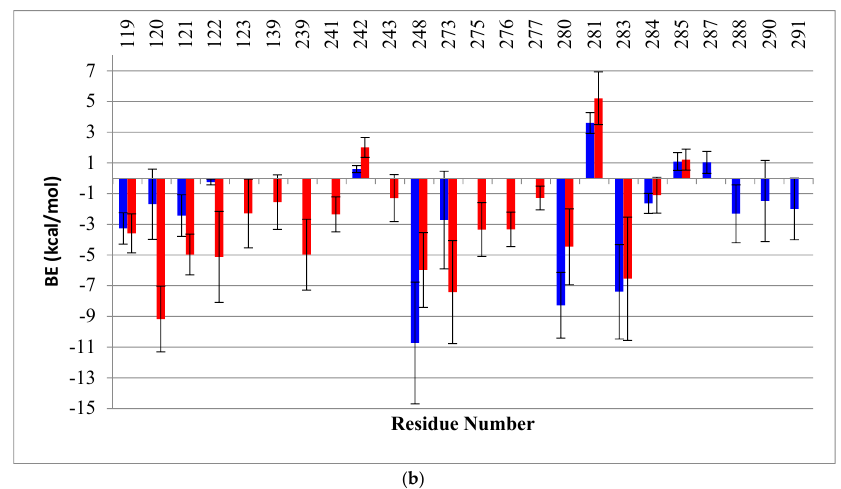
Figure 8. A histogram of the per-residue BE decomposition for ( A ) monomers A and ( B ) monomers B, each in complex with DNA for both the wt-p53 (blue) and G245S-mp53 (red). Only the residues with BE higher or lower than 1 kcal/mol are reported. The x -axis represents the residue numbers, the y -axis represents the BE and the bars represent SD. A more pronounced redistribution of BE is observed for monomer B.